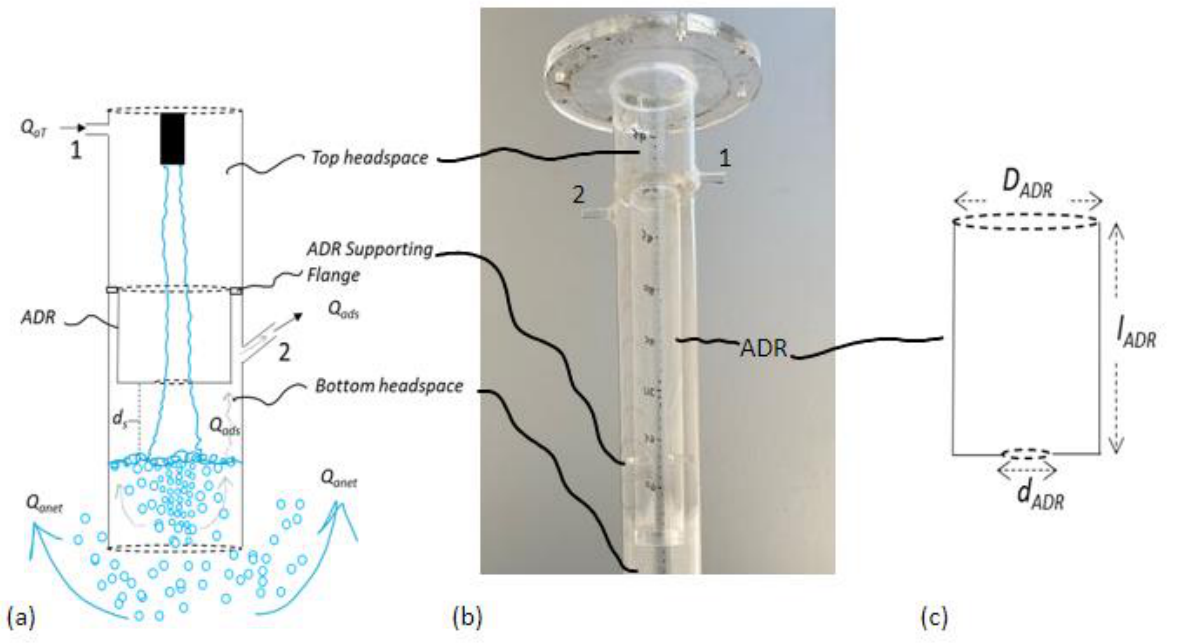
Figure 5. ( a ) Design of the novel ADR downcomer showing the ADR device. ( b ) Front view of the novel ADR downcomer showing the ADR device and other parts (ADR supporting flange, tapping 1 and tapping 2. ( c ) Design of the ADR device with dimensions.